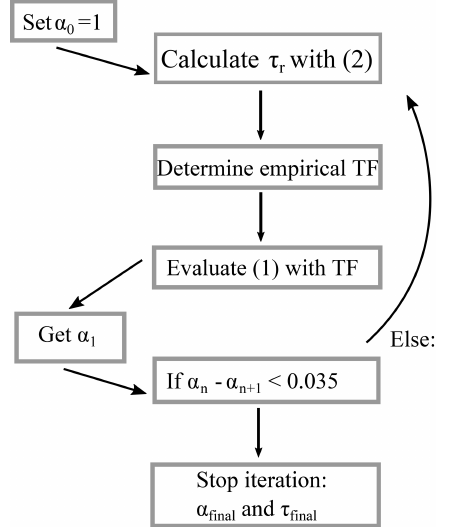
Figure 2. Illustration of the calculation of α and τ r by ICO.